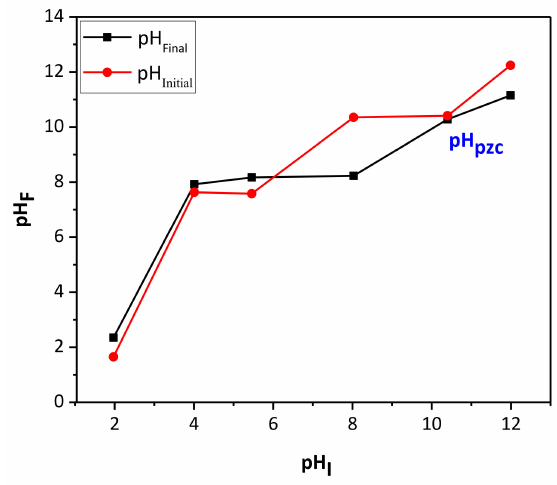
Figure 3. Determining pH pzc of NP.